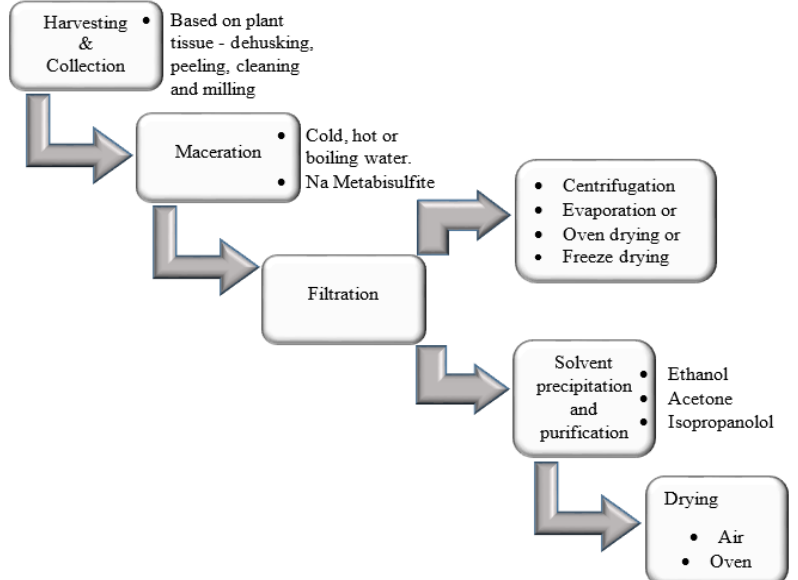
Figure 1. Schematic diagram of the general process of extraction of plant